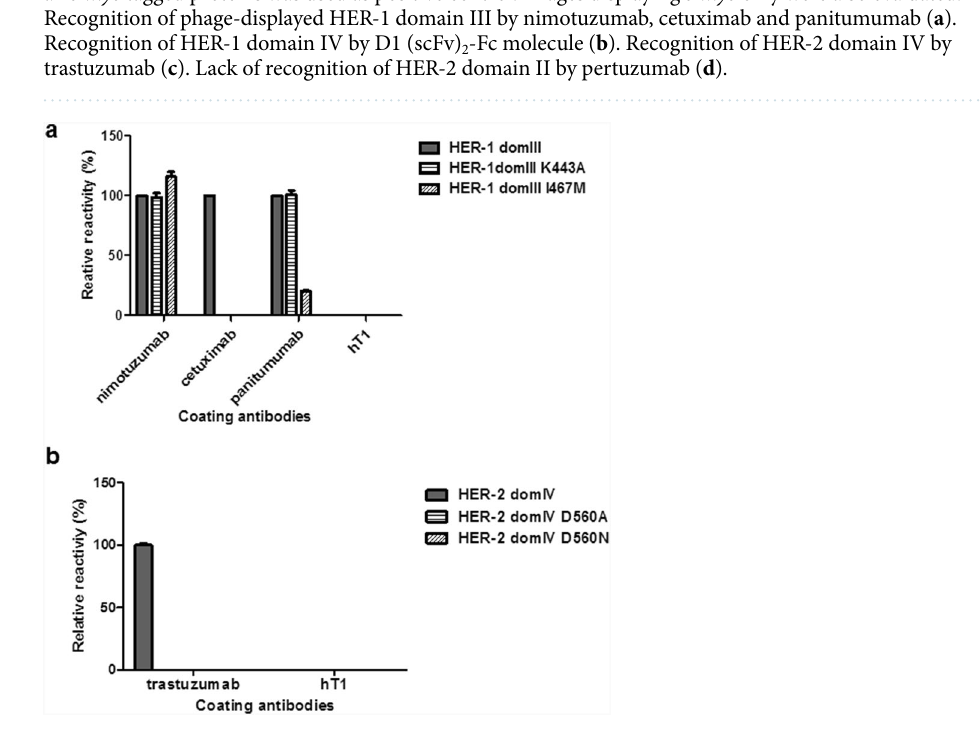
Figure 3. Recognition of mutated variants of phage-displayed domain III of HER-1 and domain IV of HER-2 by monoclonal antibodies. Purified phages displaying either wild-type (wt) or mutated HER domains were incubated on polyvinyl chloride microtiter plates coated with monoclonal antibodies. Bound phages were detected with an anti-M13 antibody conjugated to horseradish peroxidase. Relative reactivity (%) of each variant against a given antibody was calculated taking recognition of the wt non-mutated domain by the same antibody as the reference value (100%). Recognition of mutated variants of HER-1 domain III ( a ). Recognition of mutated variants of HER-2 domain IV ( b